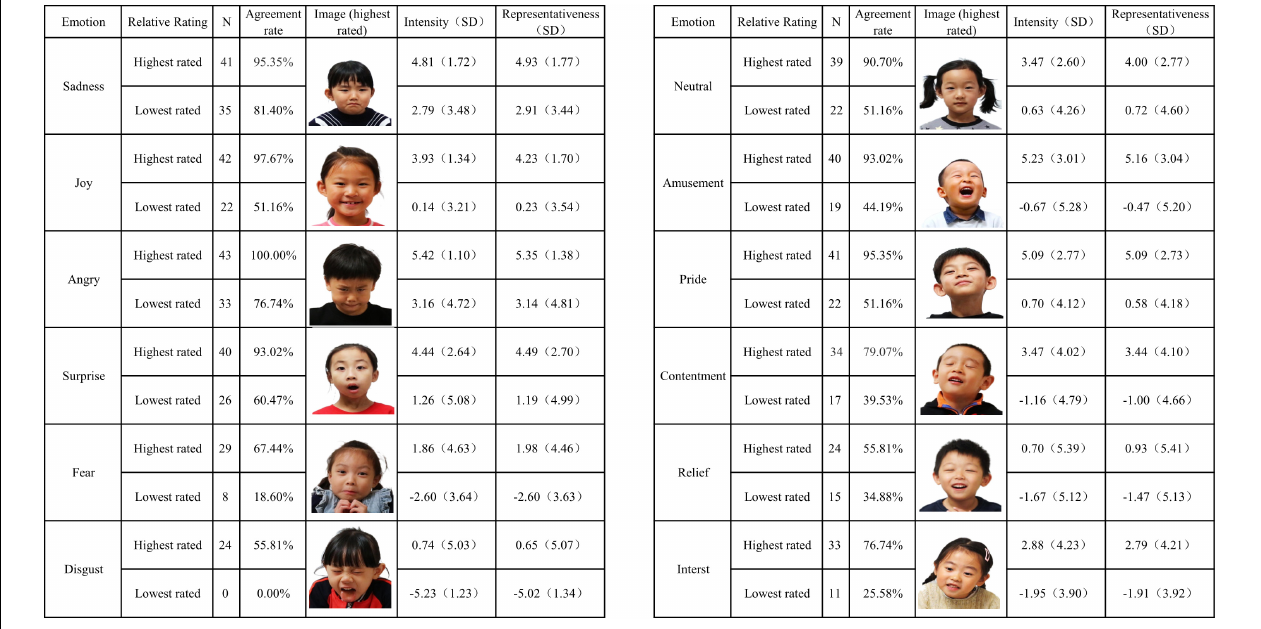
rate ( F (11,60) = 5.373, p < 0.01). Post hoc tests showed